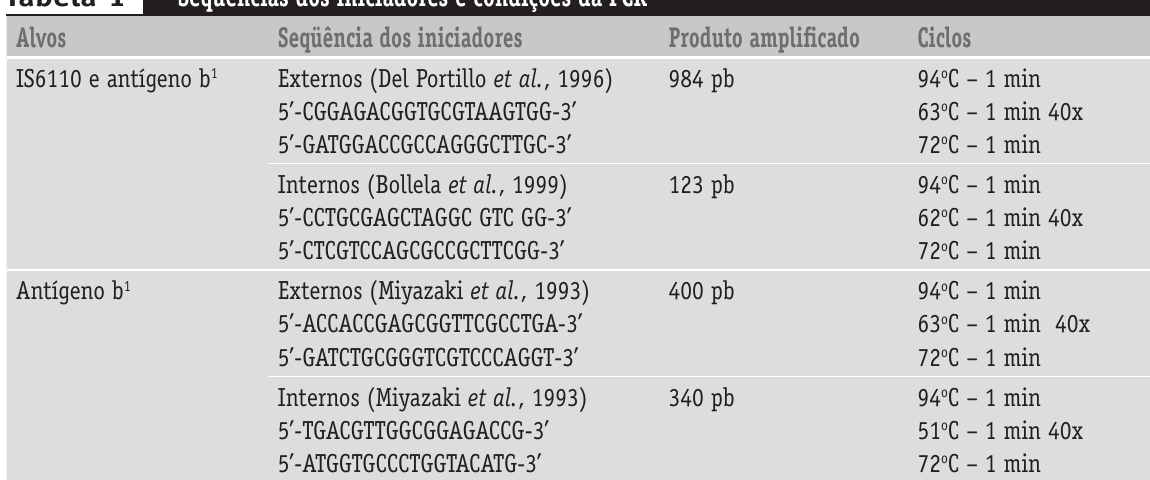
ticos (baciloscopia, cultura, nested -PCR para o antígeno b e nested -PCR para o IS6110) com os casos de